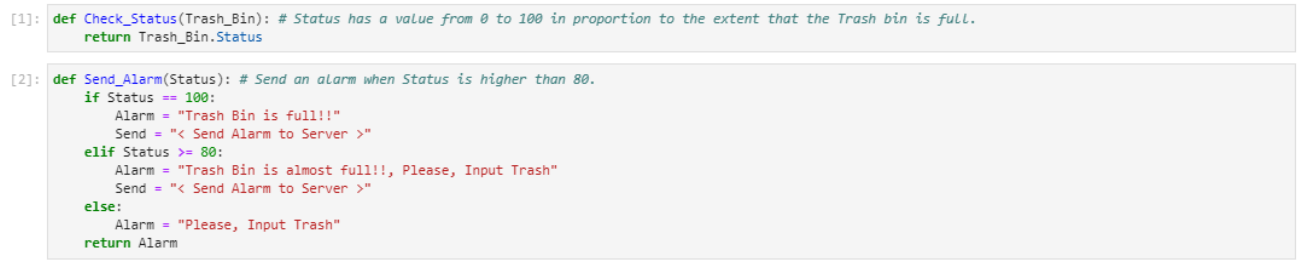
Figure A2. Define Check Status and Send Alarm Process using Python pseudocode.